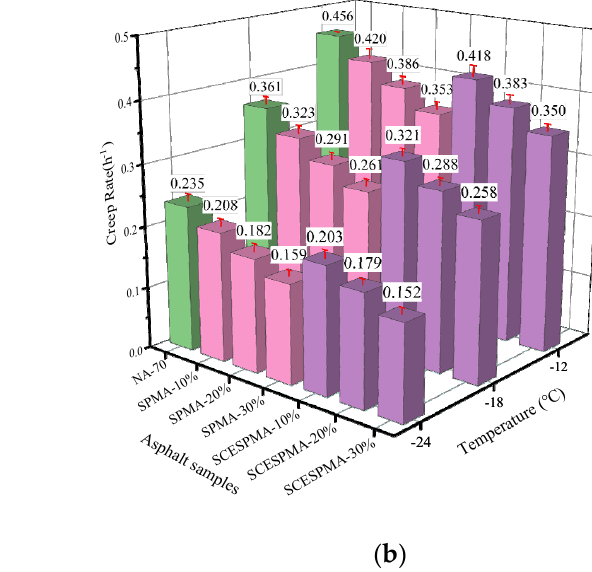
Figure 13. S and m of SPMA and SCESPMA at different temperatures. ( a ) S ; ( b ) m.